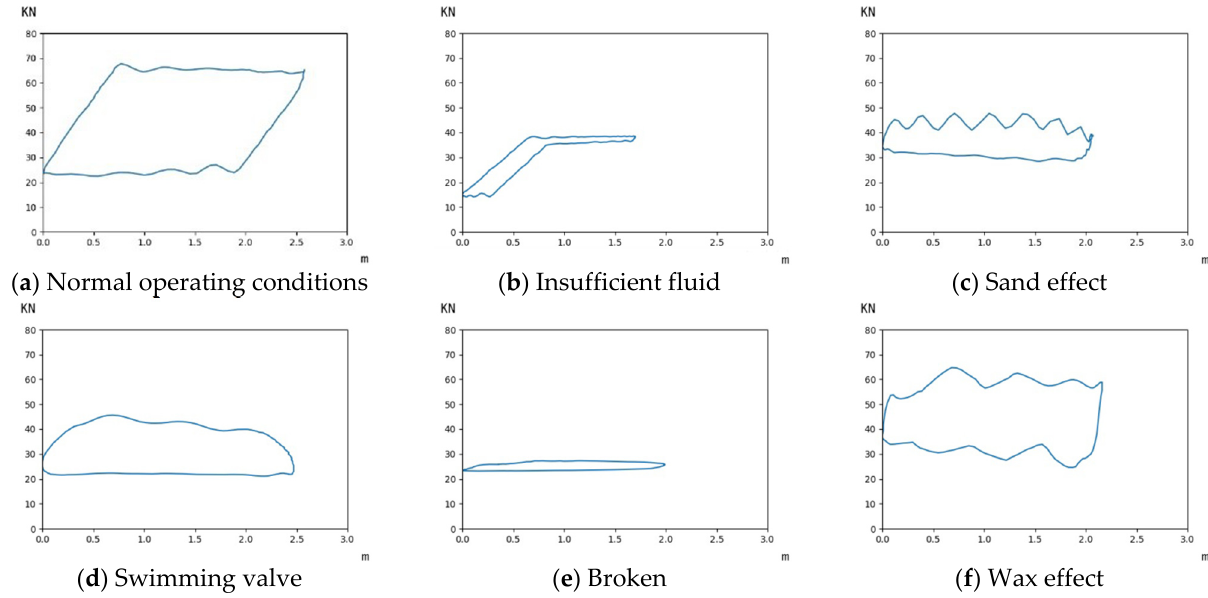
Figure 3. Example of Dynamometer Fault Types.